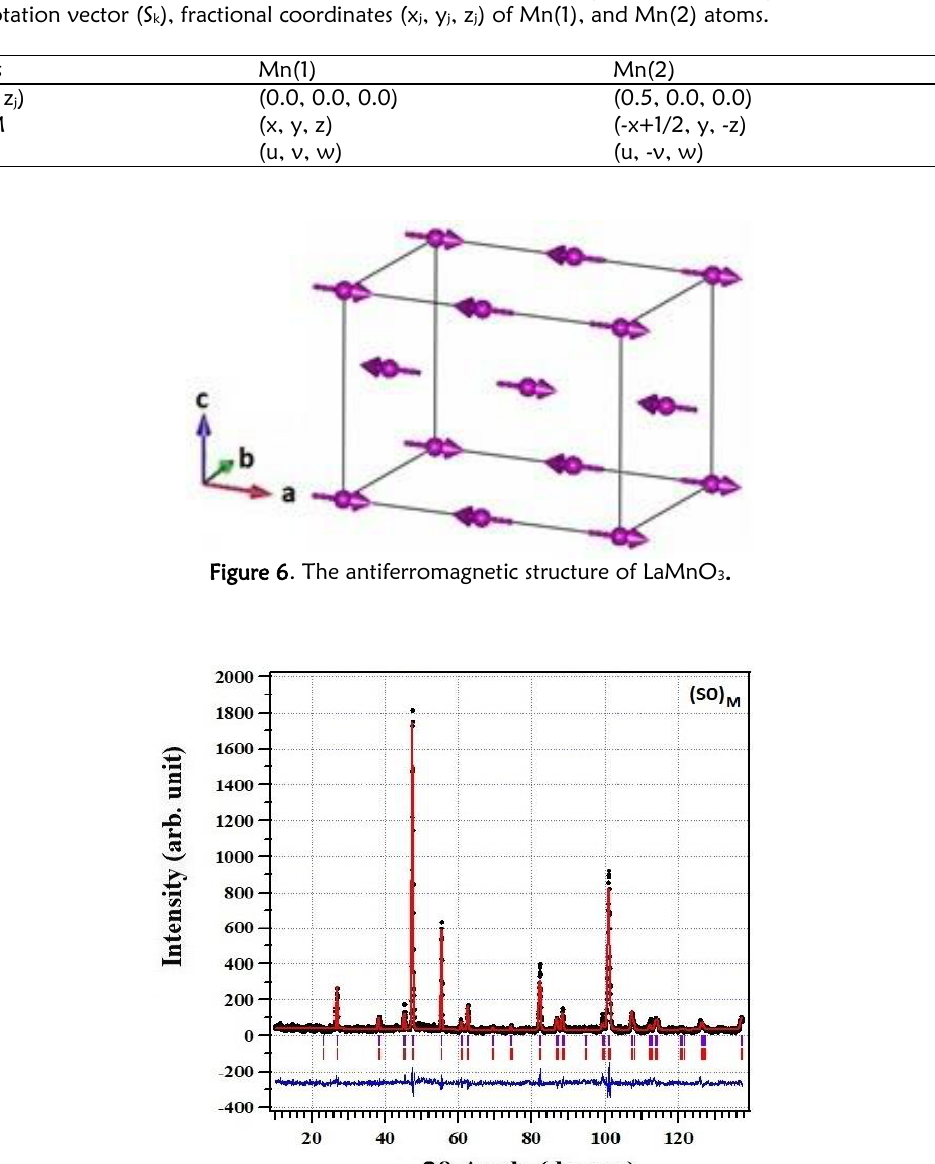
Table 8. Basis functions of Representation IRrep (3) of LaMnO 3 , space group: I12/a1, magnetic symmetry (SYMM),